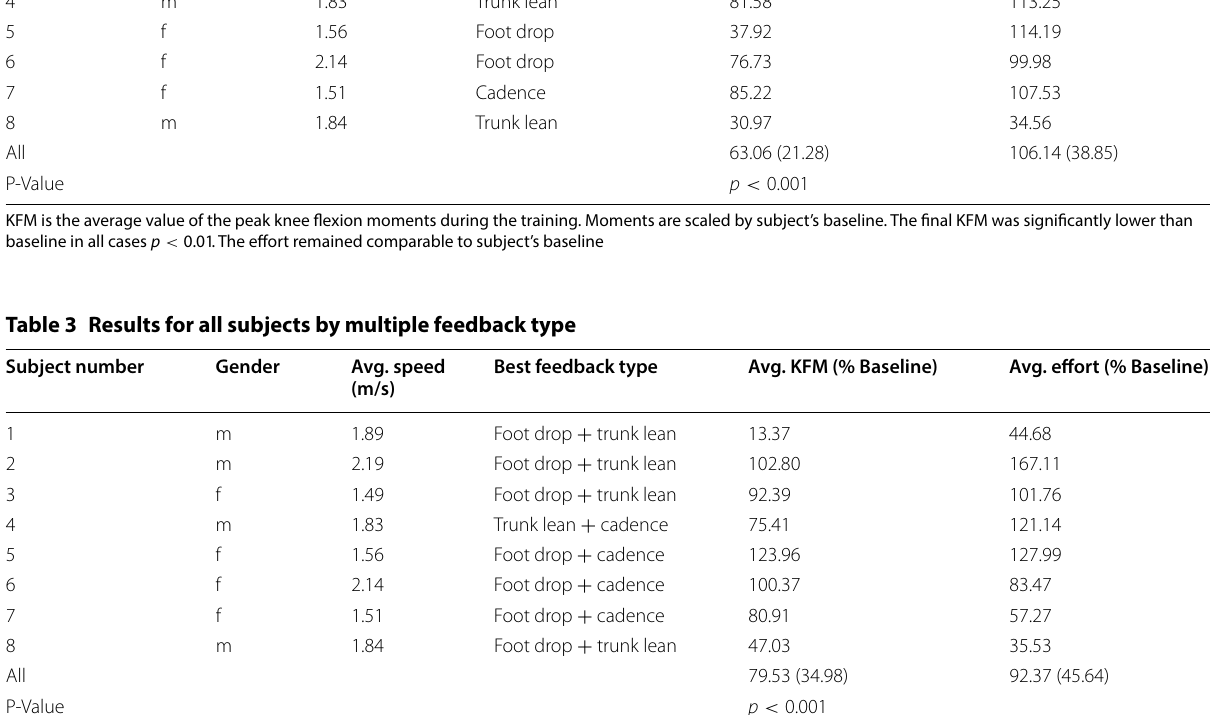
KFM is the average value of the peak knee flexion moments during the training. Moments are scaled by subject’s baseline. The final KFM was significantly lower than baseline in all cases p < 0.01 . The effort remained comparable to subject’s